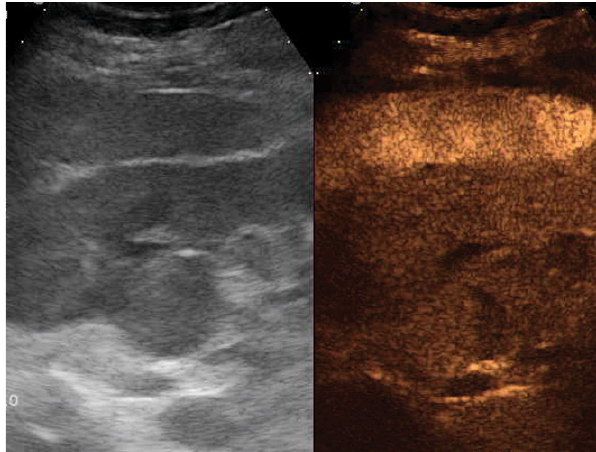
Figure 2 - The focal area of pyelonephritis in the left kidney.